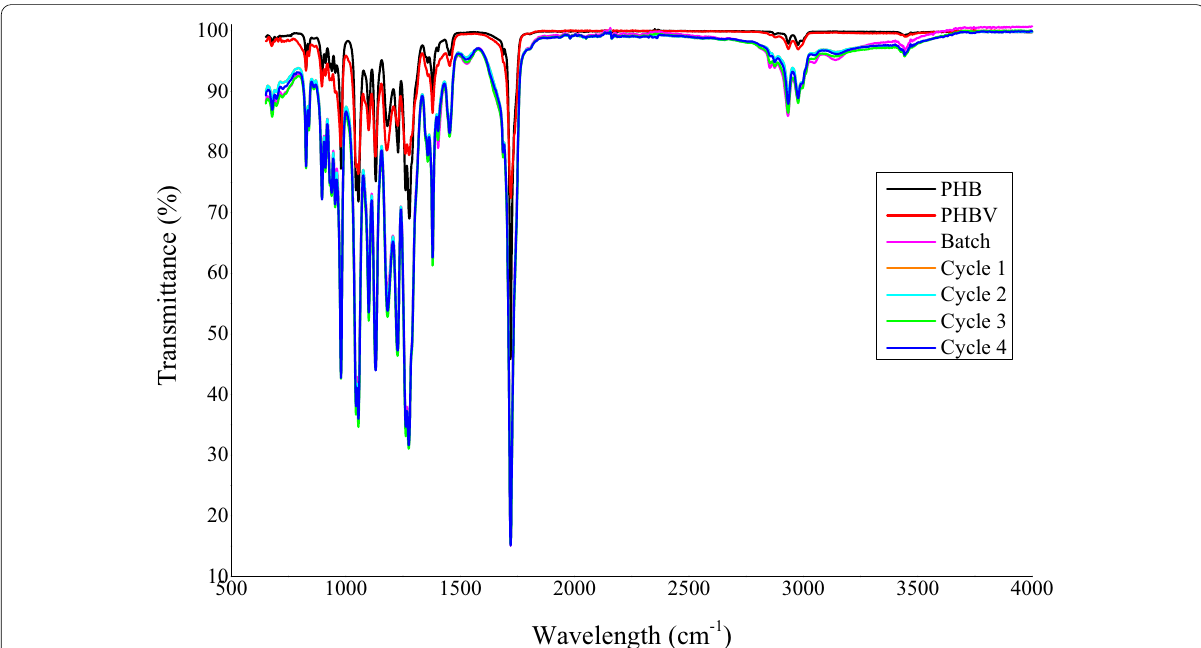
Fig. 4 FTIR spectra of commercial PHB and PHBV compared with the PHAs extracted from B. thuringiensis after each cycle of the